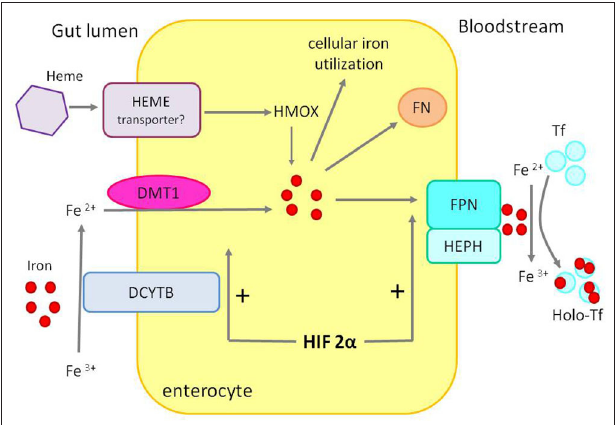
FIGURE 3 | Duodenal iron absorption. The iron transporter DMT1 takes up ferrous iron, reduced from ferric iron by DCYTB, on the enterocyte’s luminal. Iron can be used inside the cell, exported to circulation by FPN after ferrous iron is oxidized to ferric iron by HEPH or stored in FN. Heme, after entering the enterocyte through an unknown mechanism, is converted to iron by HMOX. HIF 2 α stimulates the expression of DMT1 and FPN—apical and basolateral transporters. DCYTB, duodenal cytochrome B reductase; DTM1, divalent metal transporter 1; FPN, ferroportin; HEPH, hephaestin; HMOX, heme oxygenase; FN, ferritin; Tf, transferrin; Holo-Tf, holotransferrin.